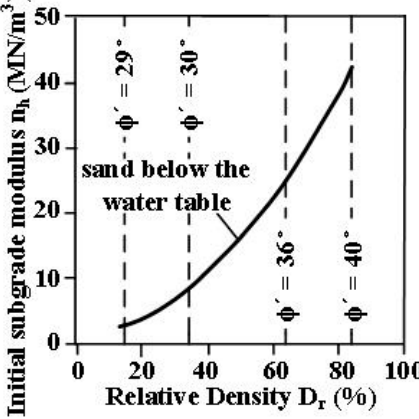
Figure 1. Relationship of the initial modulus of subgrade reaction, the effective friction angle, and relative density.